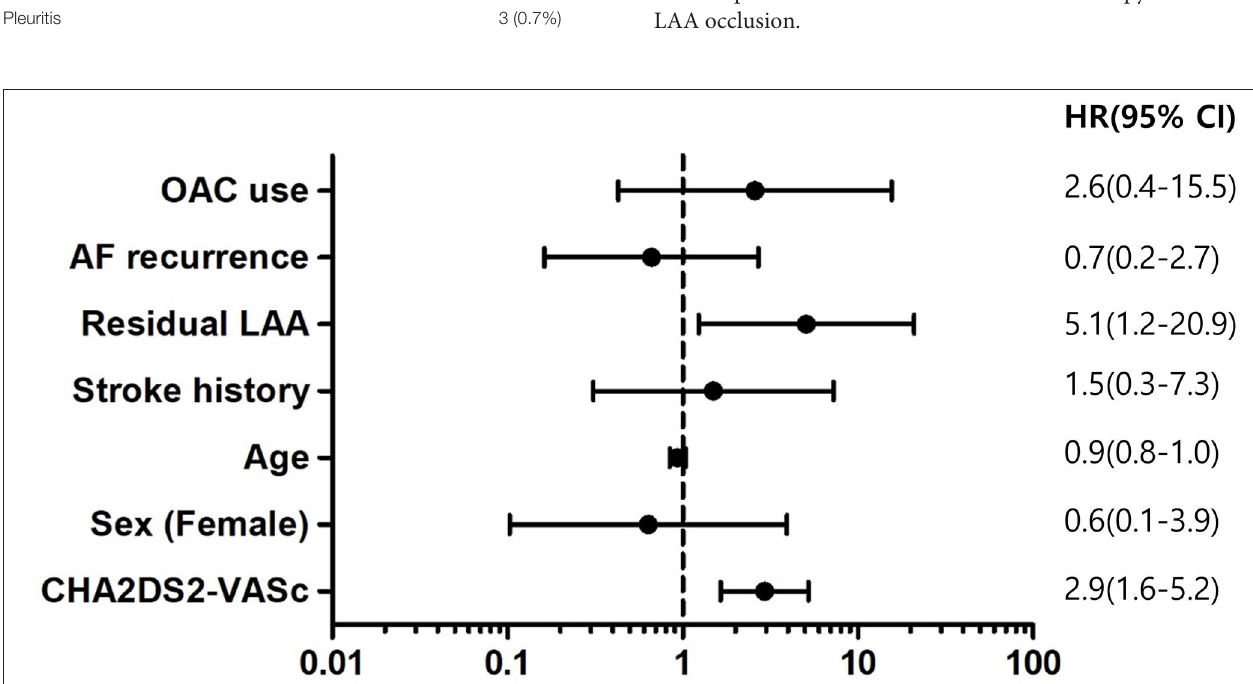
FIGURE 6 | Hazard ratios for ischemic